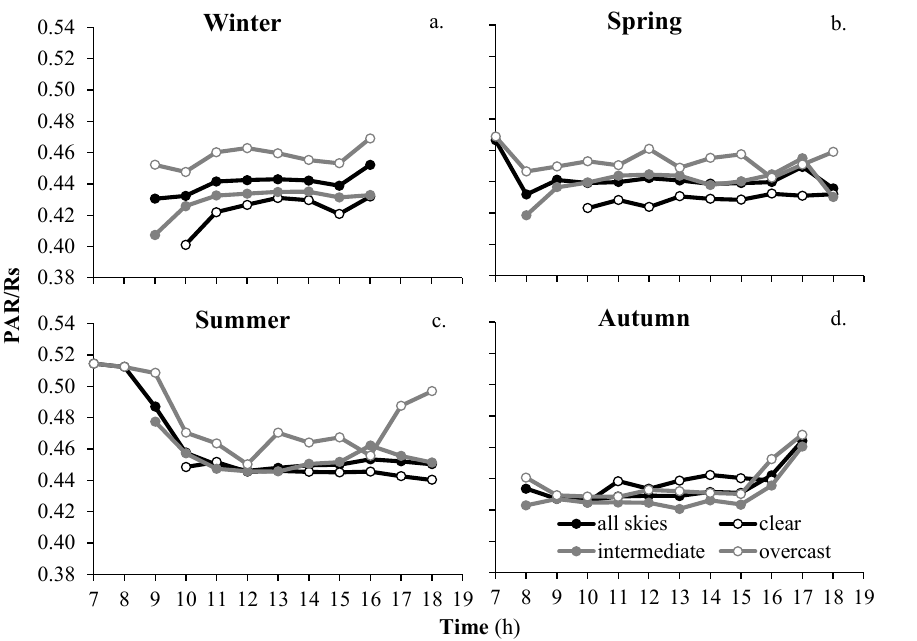
Figure 5. Diurnal variation of the PAR/Rs hourly average values during the different seasons of the year: ( a ) winter, ( b ) spring, ( c ) summer and ( d ) autumn, under overcast, intermediate, clear, and all sky conditions.